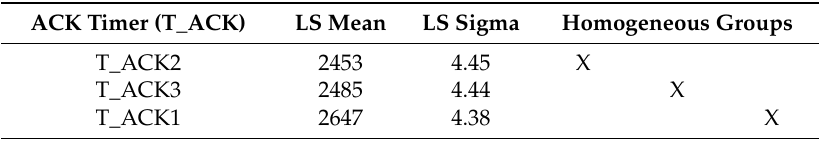
Table 11. Results of the Multiple Range Tests for the factor ACK Timer (T_ACK) using as dependent variable Convergence